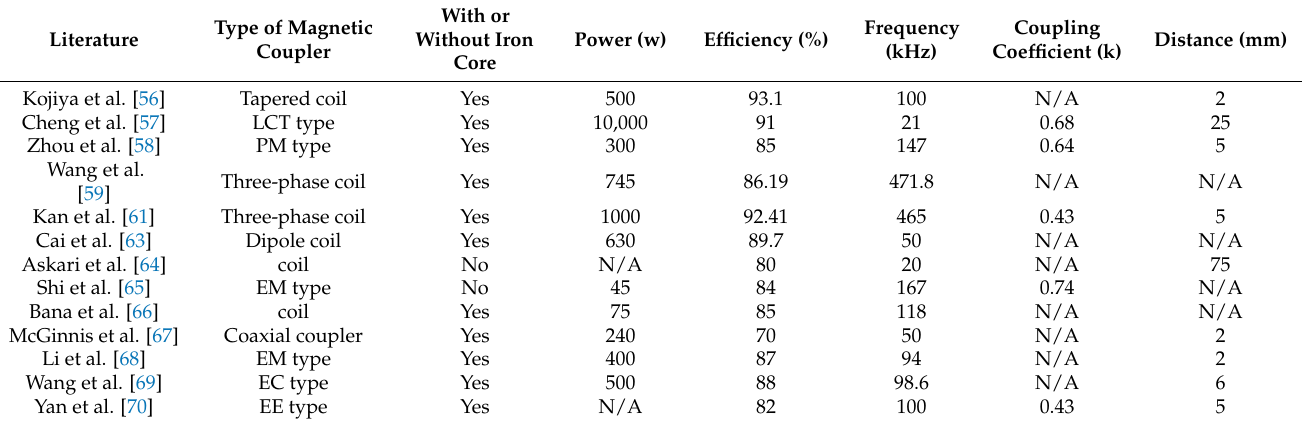
Table 1. Comparison of various IWPTs using resonant coils.